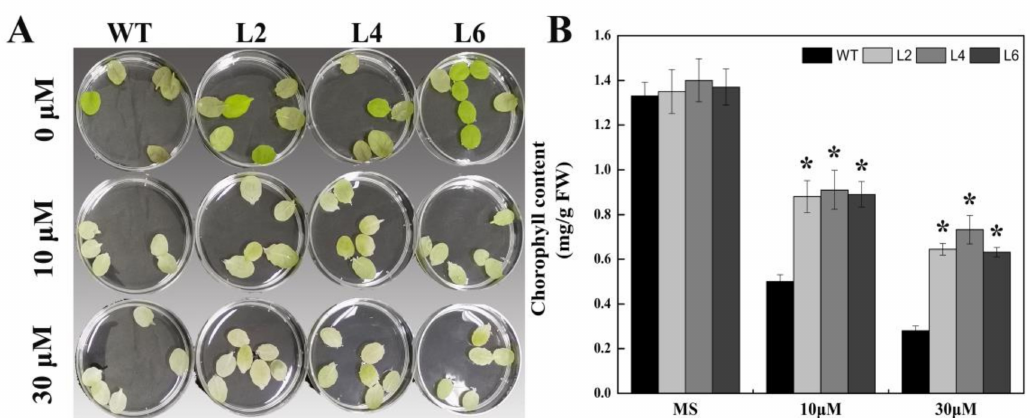
Figure 8. Comparison of the oxidative stress tolerance between the WT and the transgenic plant leaves. ( A ) The leaves of three-week-old L2, L4, L6 and WT Arabidopsis were treated with methyl viologen (MV) at concentrations of 0, 10 and 30 µ M for 24 h. ( B ) Chlorophyll content in the leaves after stress treatment. Each value is based on three biological replicates, and the error bars represent ± SD. *Indicates significance compared with the WT ( p <